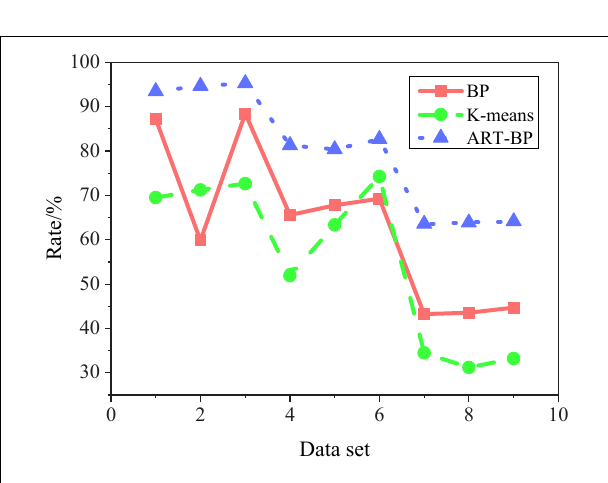
FIGURE 7 | Comparison of experimental results and accuracy of three algorithms.